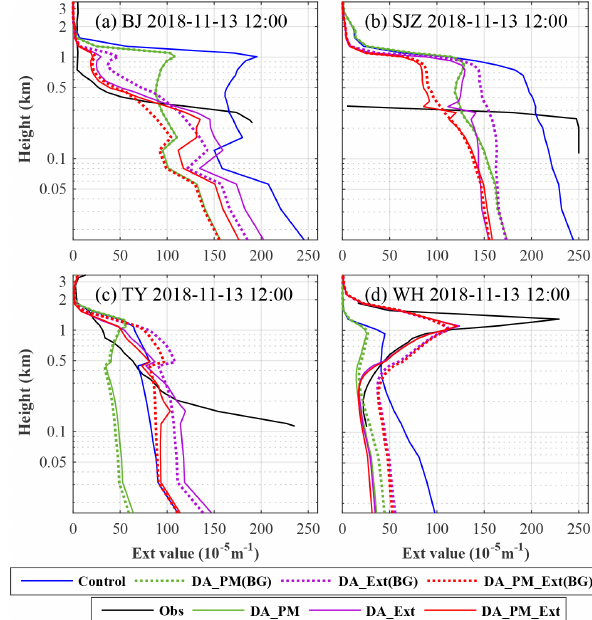
Figure 6. AEC profiles measurements (solid black lines), the AEC profiles in the control experiment (solid blue lines), in the back- ground field of the DA_PM (dotted green lines), DA_Ext (dotted purple lines), and DA_PM_Ext (dotted red lines) experiments, and in the analysis fields of the DA_PM (solid green lines), DA_Ext (solid purple lines), and DA_PM_Ext (solid red lines) experiments at four lidar stations at 12:00UTC on 13 November 2018 (BJ: Bei- jing; SJZ: Shijiazhuang; TY: Taiyuan; WH: